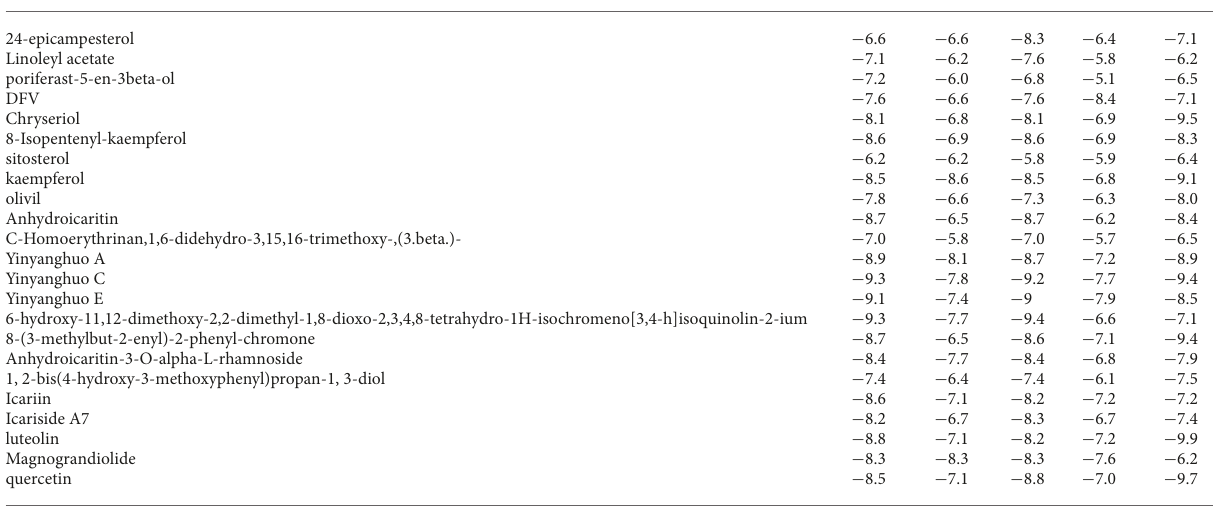
TABLE 4 The results of molecular docking (kJ/mol).